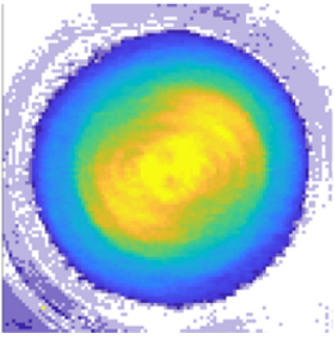
Figure 5. Linear amplitude of 2D field scan with approx. 1 % LP e content (scaling factor 21